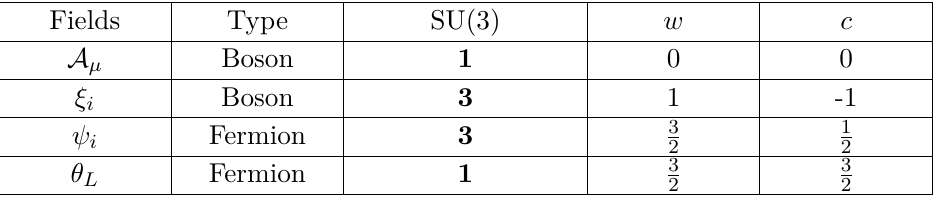
Table 2 . Fields of the N = 3 vector